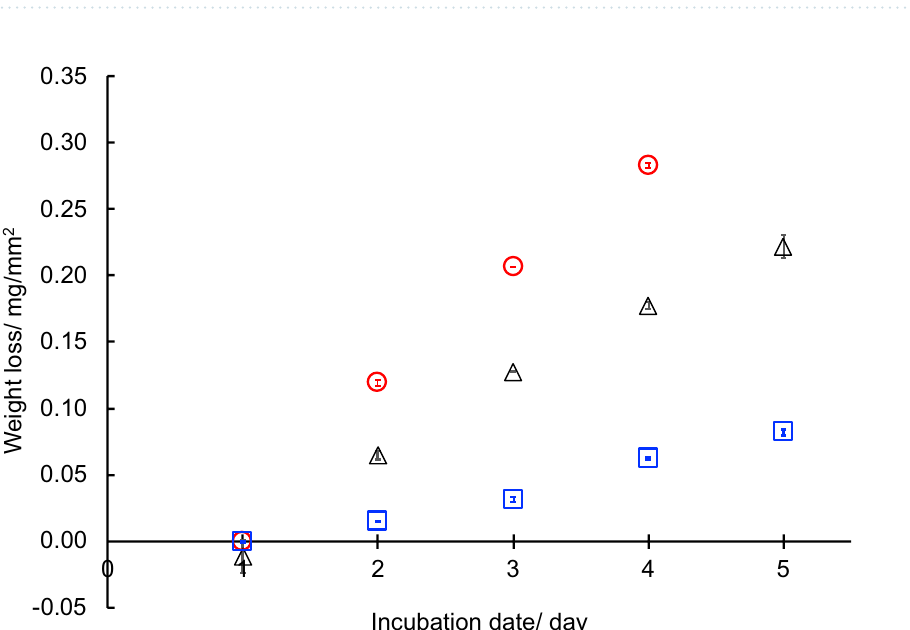
Figure 4. Photograph of compression-molded BP1 sheets used in enzymatic degradation testing.